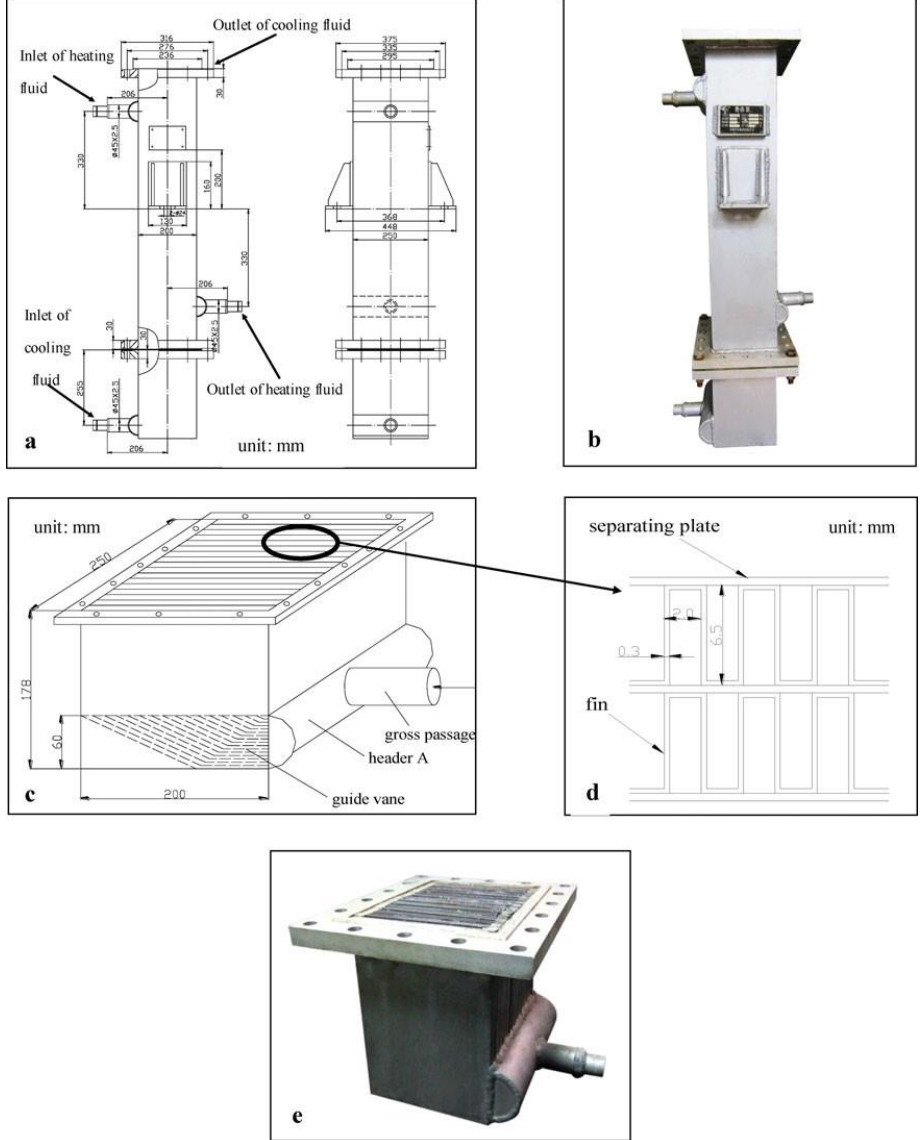
Figure 1. ( a ) Schematic drawing of a PFHE ( b ) Photograph of a PFHE ( c ) Schematic drawing of